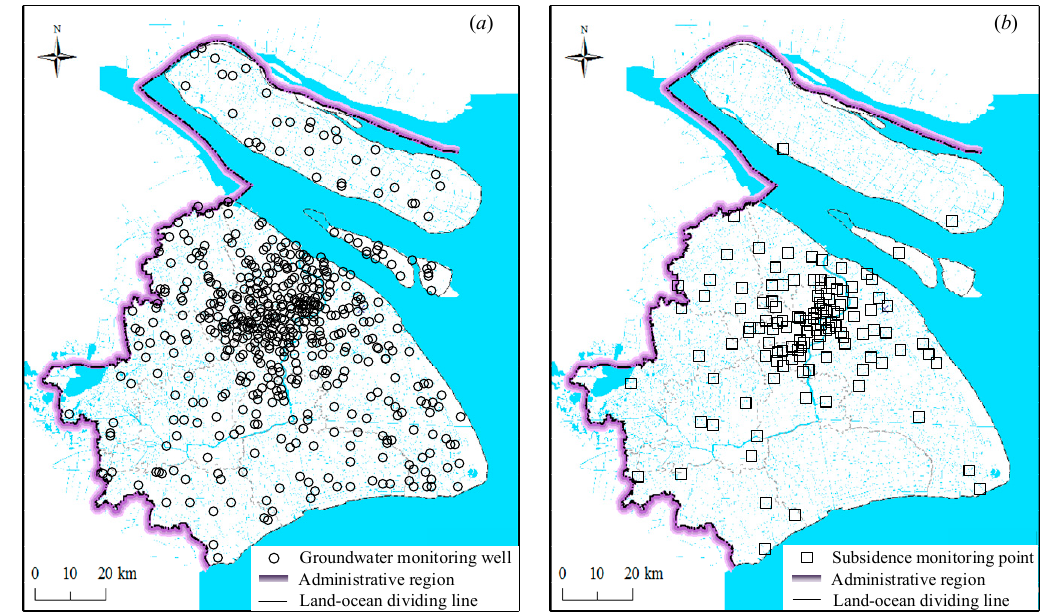
Figure 5. Monitoring networks in Shanghai: ( a ) Groundwater detecting network, ( b ) land subsidence monitoring network (redrawn used the data from Reference [38]).